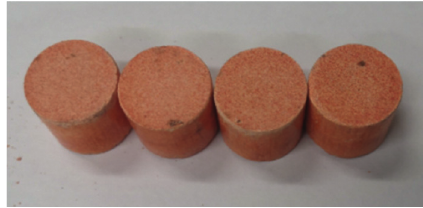
Figure 6: Pressed grain.